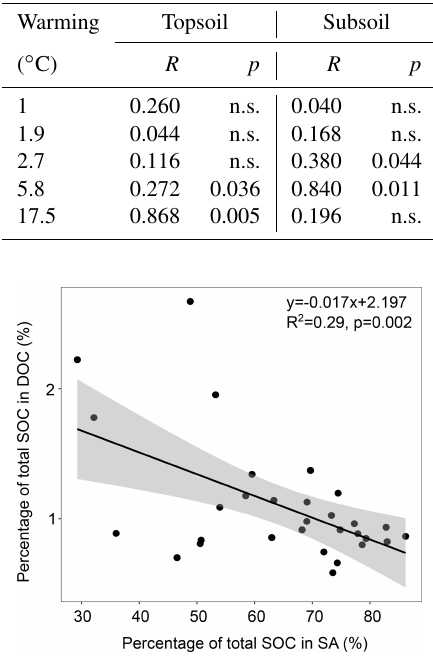
Figure 3. Correlation between the proportion of soil organic car- bon (SOC) in the sand and aggregates (SA) and dissolved organic carbon (DOC) fractions in the topsoil with the 95% confidence in-